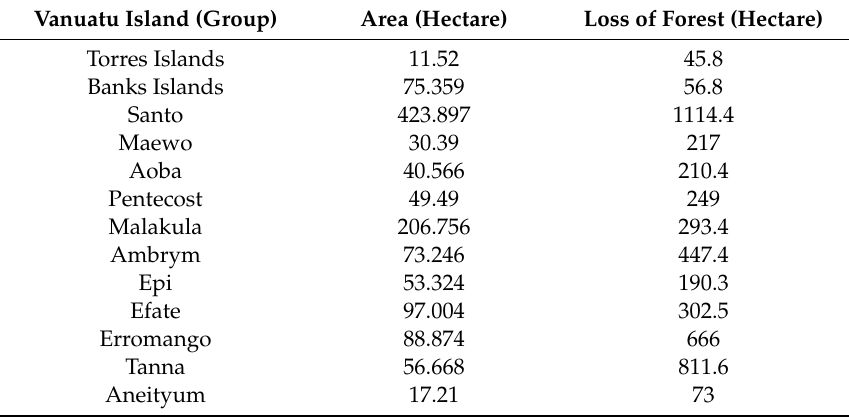
Table 5. Statistics of forest loss derived from satellite data analysis of 1990–2000. Vanuatu Island (Group) Area (Hectare) Loss of Forest